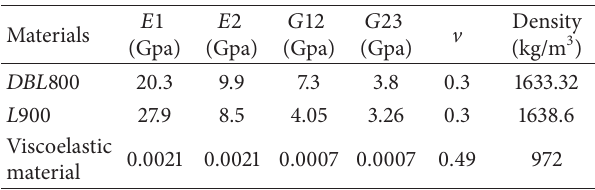
Table 1: Material properties.